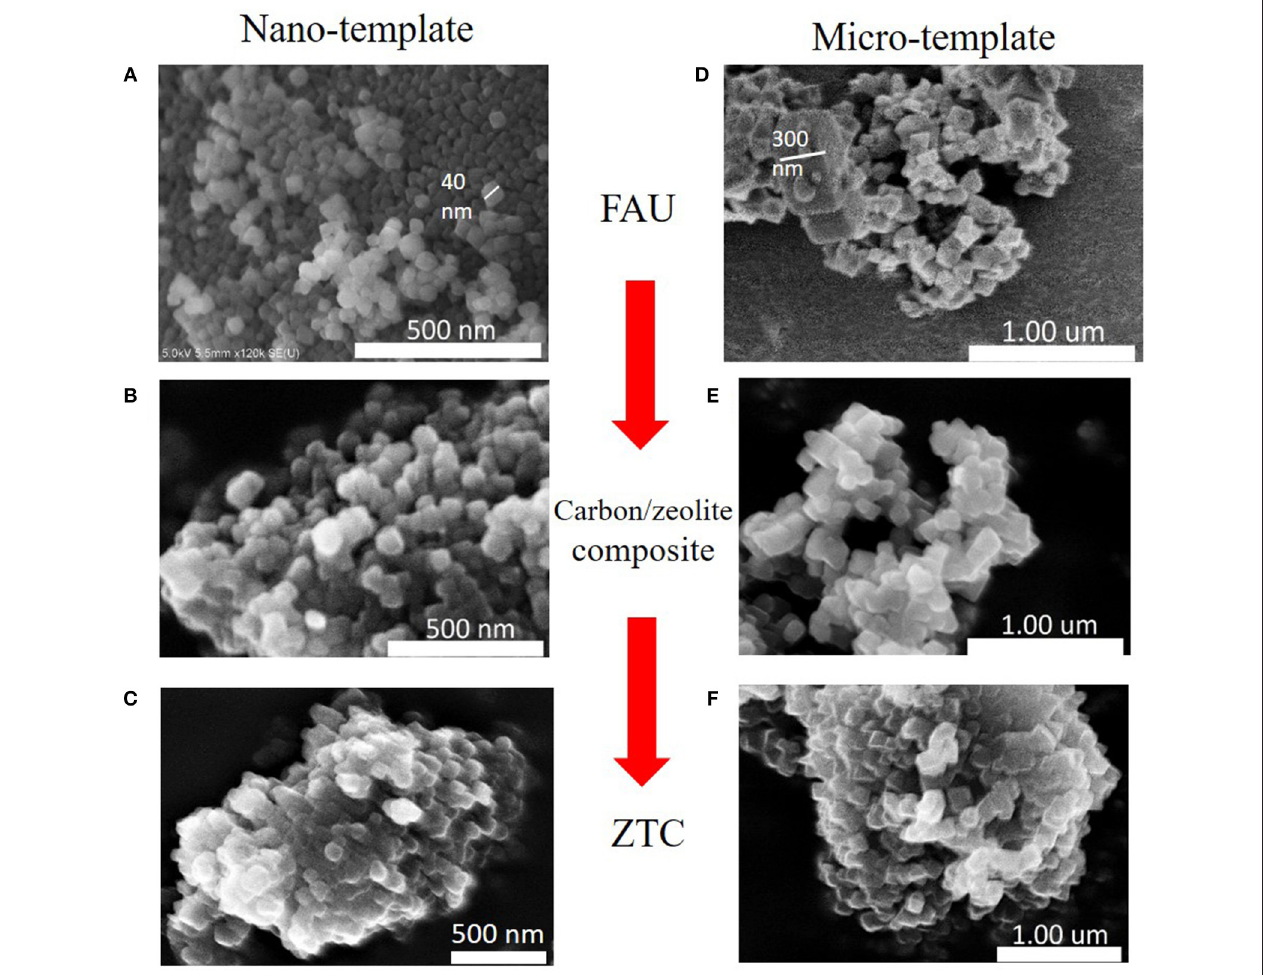
FIGURE 2 | SEM images of the various stages of ZTC preparation; (A) 40nm FAU (nano-FAU), (B) carbon/nano-FAU composite, (C) liberated ZTC40, (D) 300nm FAU (micro-FAU), (E) carbon/micro-FAU composite, and (F) liberated ZTC300.